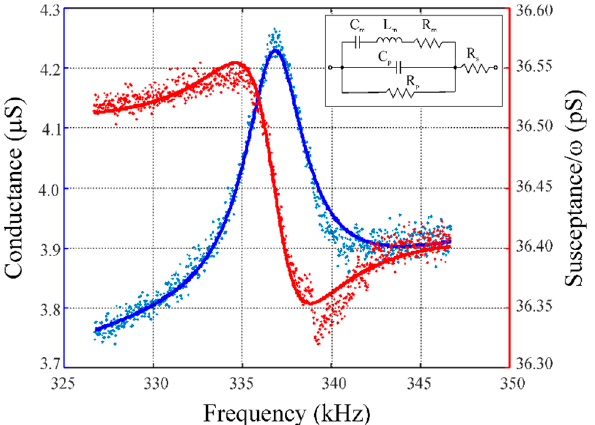
Figure 5. Electric impedance spectrum (dotted line) for a 1500 × 900 × 40 µm 3 cantilever near the first order roof tile-shaped mode frequency in isopropanol. The peak represents the motional response of mode under study and from the fitting to the circuit model (solid line) the figures of merit of the resonance can be deduced. Inset: modified Butterworth–Van-Dyke equivalent electrical circuit for a piezoelectric resonator.